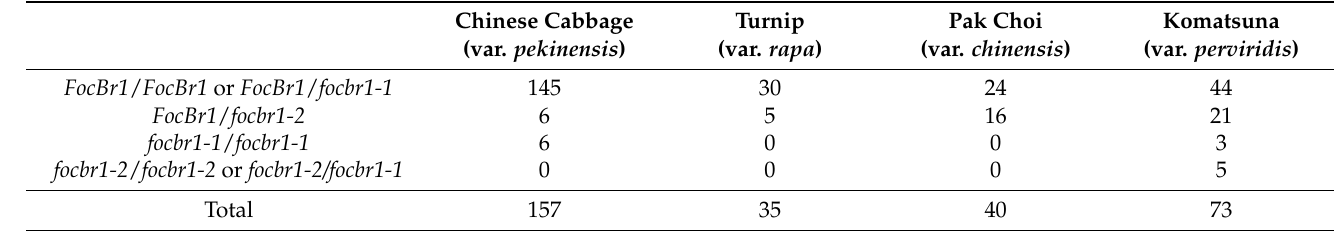
Table 4. Genotype distribution of FocBr1 in B. rapa